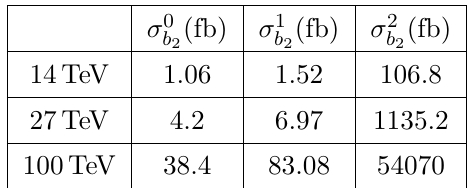
, σ 1 , and σ 2 in the expression (4.2) for pp → hhjj at three different b 2 b 2 b 2